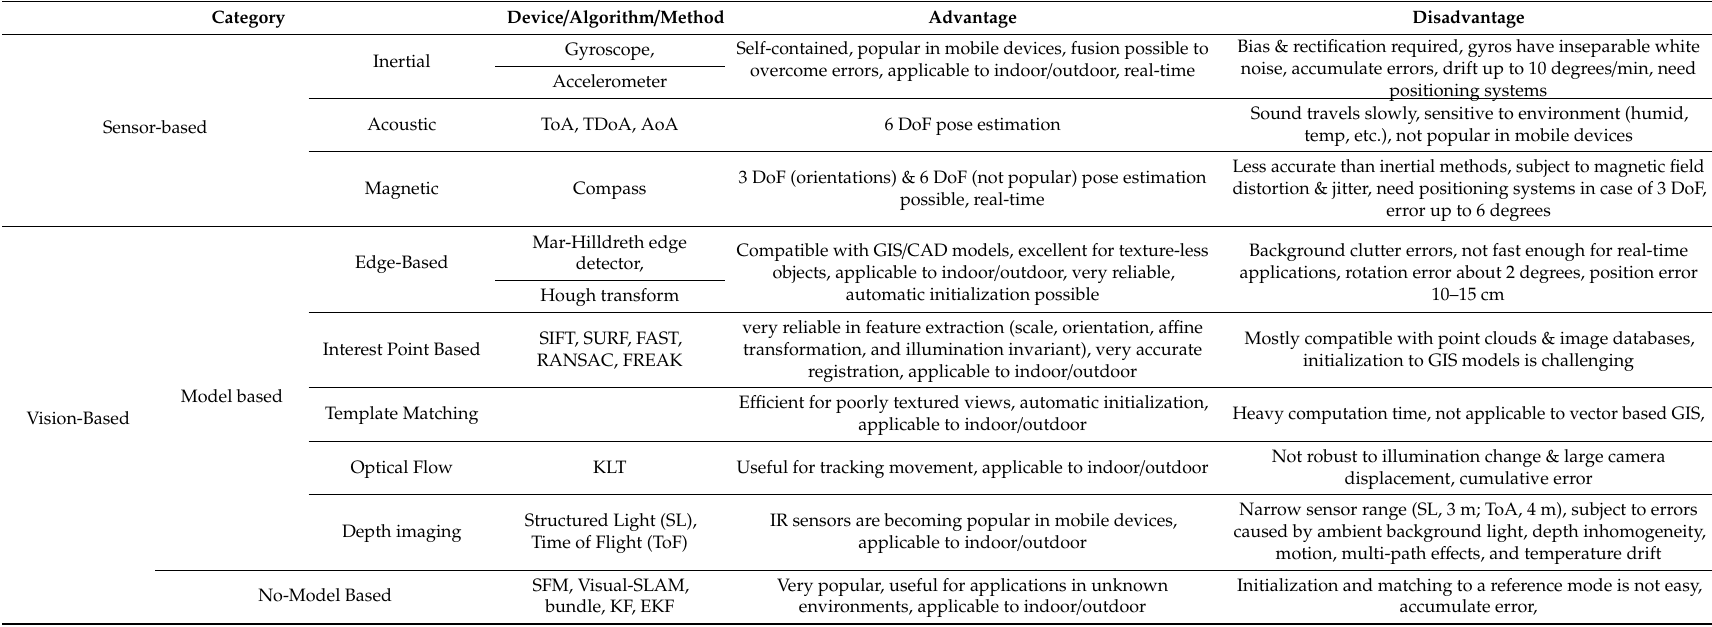
Table 4. Summary of advantages and disadvantages of pose estimation and